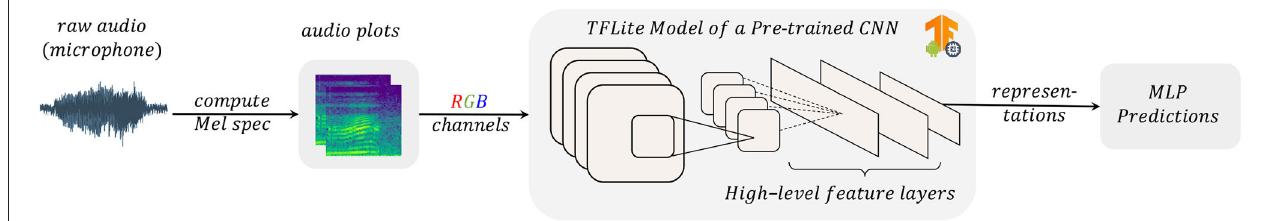
FIGURE 1 | A general overview of a DEEPSPECTRUMLITE model deployed on a target device for inference. Raw audio (from the device’s microphone) is first converted to a spectrogram representation and the values are mapped to the red-green-blue (RGB) color space according to a certain color mapping definition. These spectrogram plots are then forwarded through the TFLite version of a trained CNN model, and an MLP classifier head generates predictions for the task at